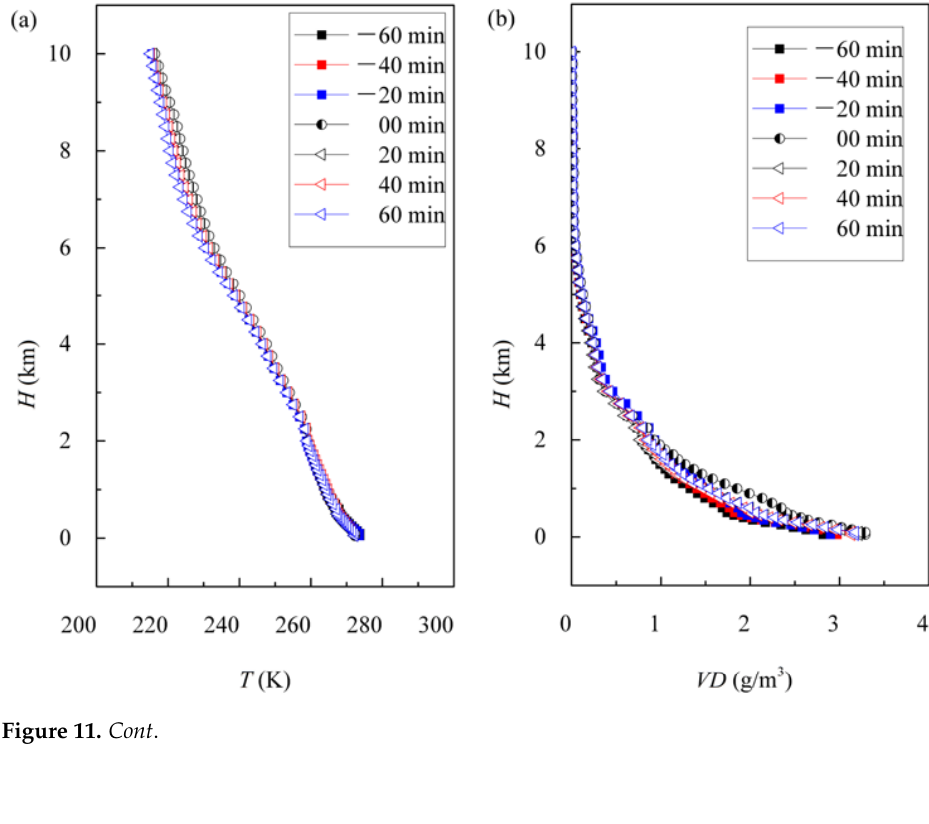
Figure 11. Comparison of temperature ( a ), vapour density ( b ), liquid water content ( c ), and relative humidity ( d ) profiles before and during the snow process. The time instant t t (h) = 0 h represents one hour before the precipitation process. 4.2. Quantitative Snowfall Estimation Snowfall estimation was investigated for near-ground MWR measurements. Figure 12 shows that the LWV in the zenith direction of the field site exponentially increased with PWV , especially on snowy days. For scattergrams of PWV and LWC against R , there was no clear relationship between PWV and R , but LWC generally increased with increasing R , which was also mentioned in the work of Jeoung et al. [42].